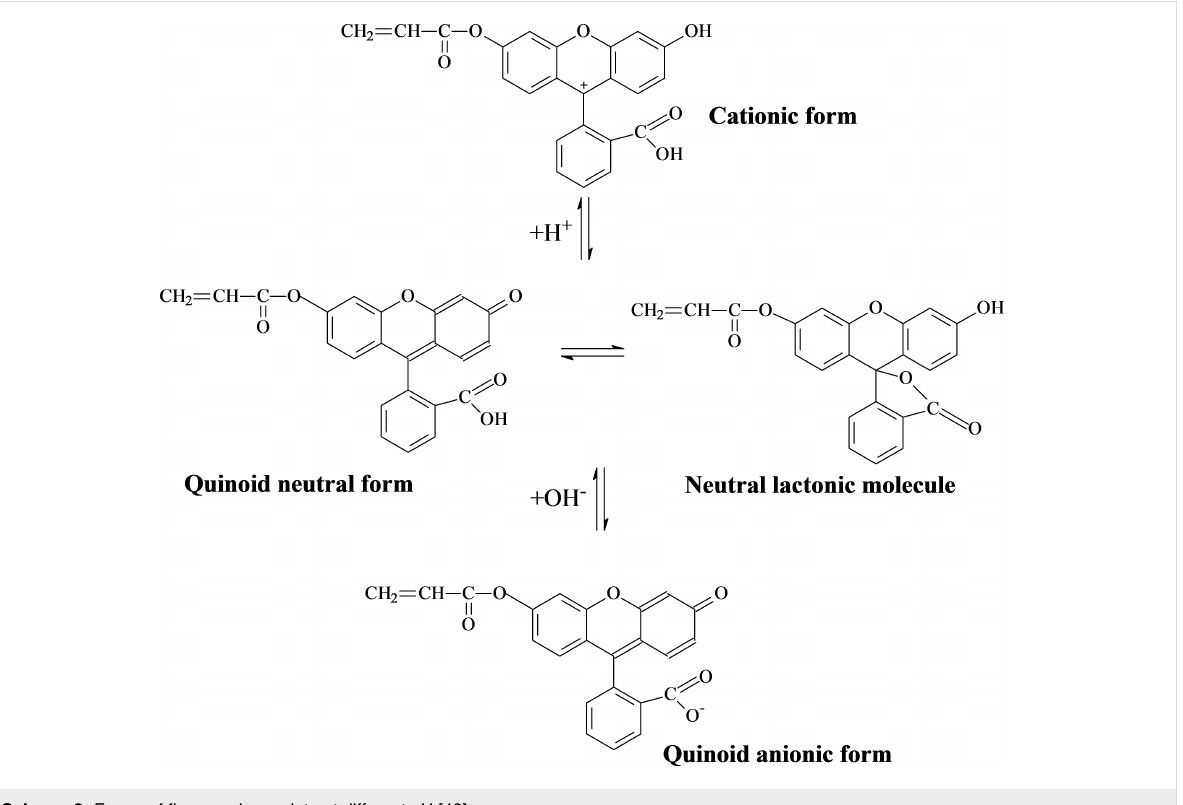
contrast, at pH 6 (Figure 7, yellow line) a strongly shifted, small, intense absorbance peak is observed. At pH 4 (Figure 7, green line) the absorbance is very poor, and we can state here that it has no absorbance. Only at pH 2 (Figure 7, brown line) do we observe a maximum fluorescein absorption at 437 nm